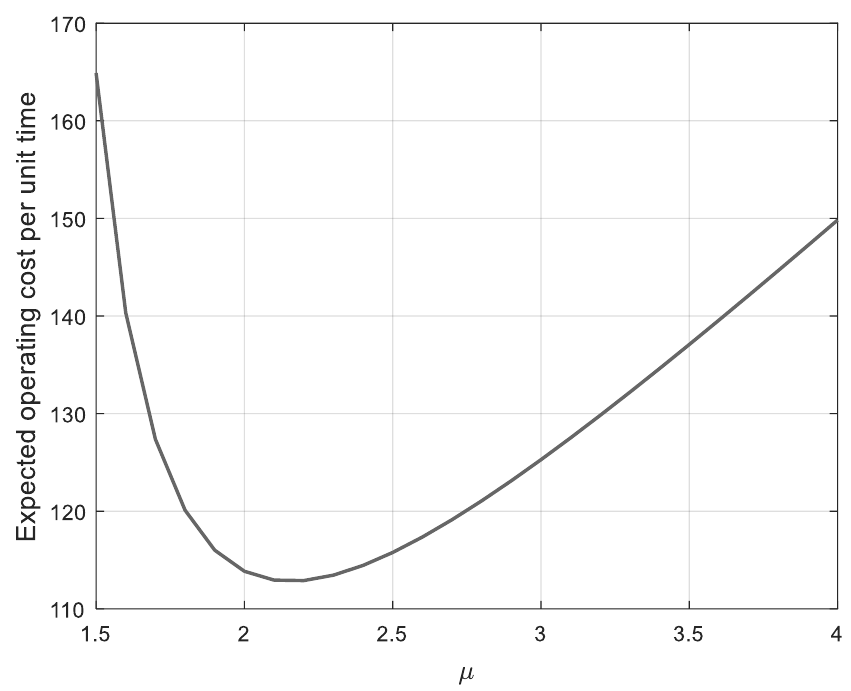
Figure 6. Variation in expected operating cost per unit time with service rate